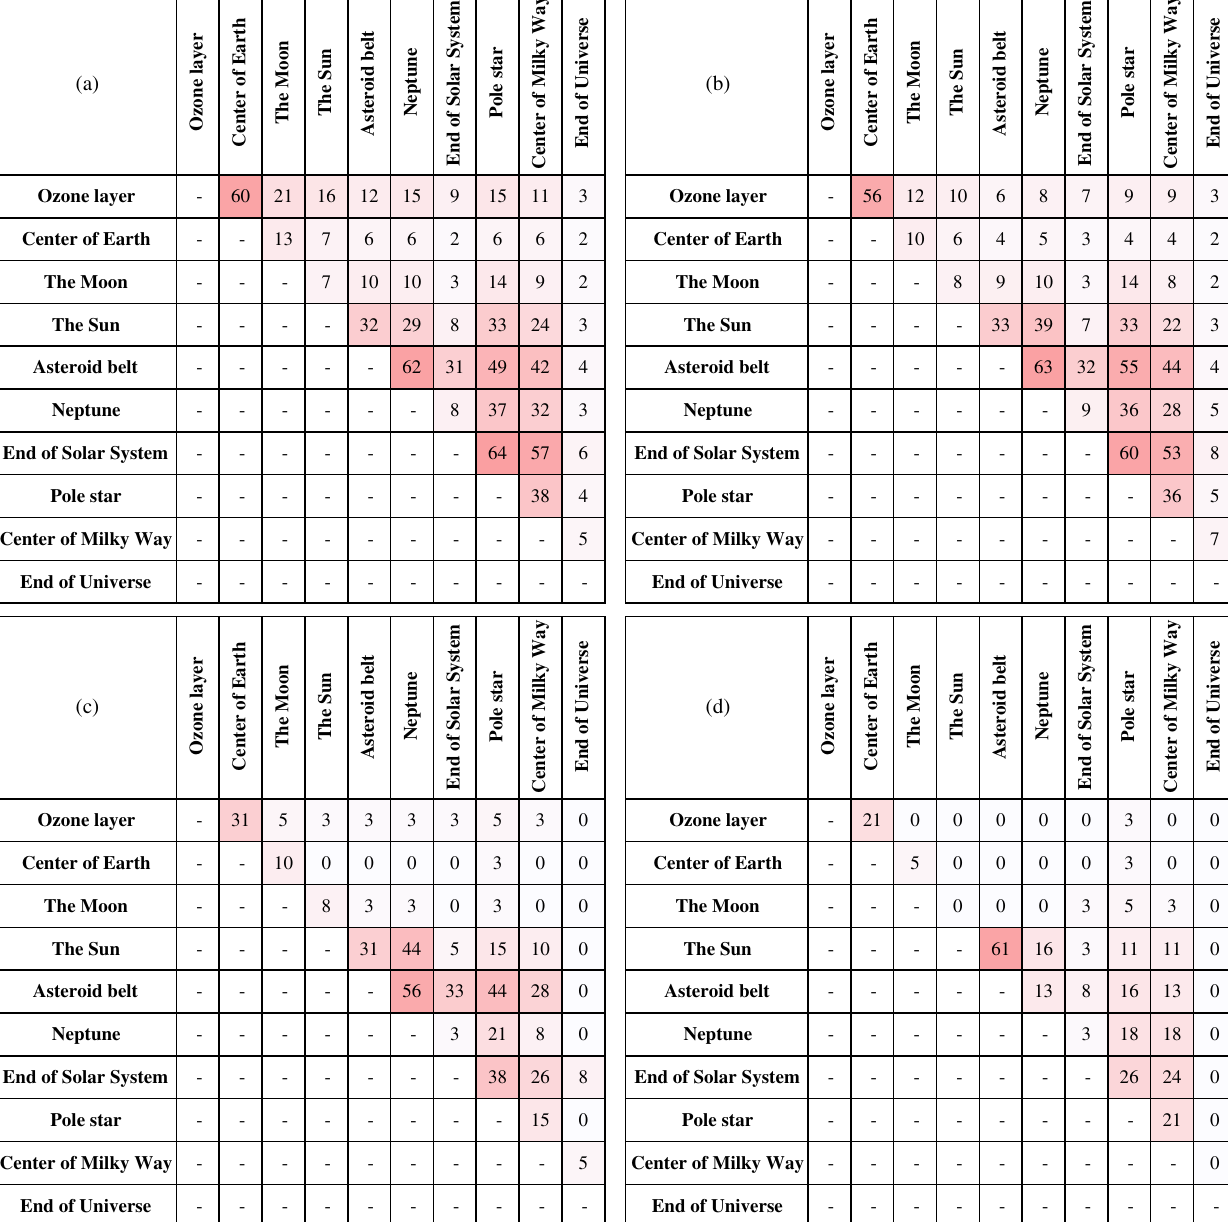
FIG. 6. Percentages of students that made specific pairwise errors on the distance ranking task in Q7; the sample groups (a) – (d) match those in Fig. 5, while the matrices here should be interpreted in the same way as those in Fig. 3. For example, matrix (b) tells us that 60% of the preinstruction middle school students wrongly ranked the end of the Solar System as being further away from Earth ’ s surface than the Pole star, regardless of the absolute ranks they assigned to either object or to any other objects, while a third of them wrongly thought that the Sun is further away from Earth ’ s surface than is the Pole